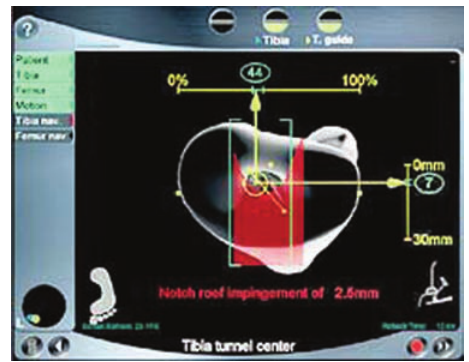
Figure 4 - Tibial guide navigation screen. Target parameters correspond to the green interval on the superior and lateral